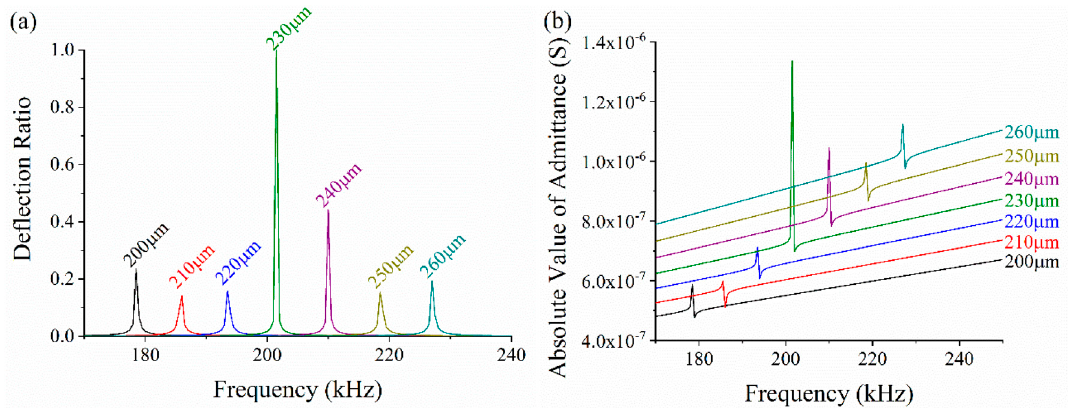
Figure 9. The FEA simulation results of parametric sweeping. ( a ) Deflection displacement under conditions of various radii, ( b ) the absolute value of admittance. Table 3. The resonant frequencies with di ff erent radii of top